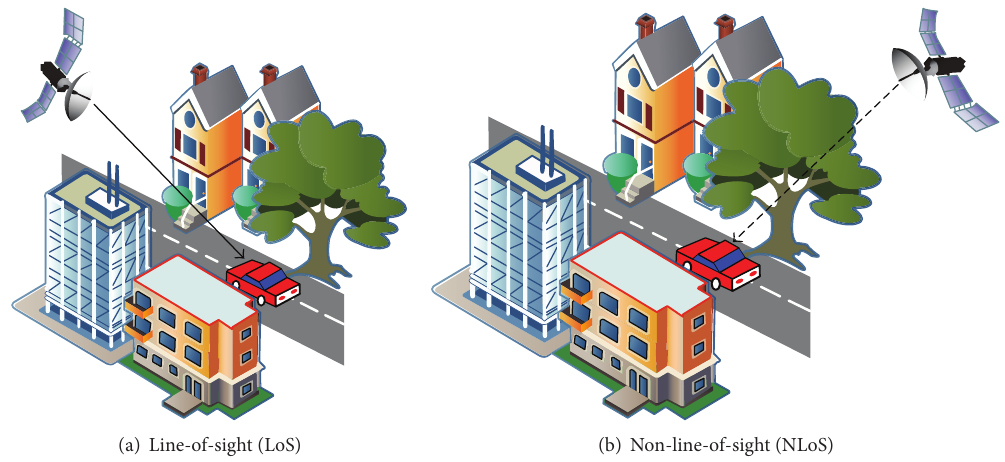
Figure 2: The mobile user can be situated in different receiving states, which depend on the surrounding objects and the azimuthal angle relative to the driving